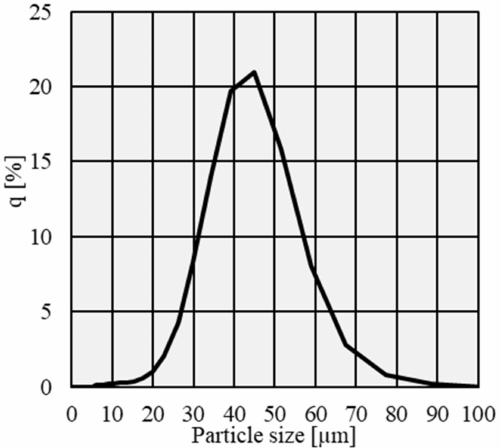
Figure 2. Particle size distribution of AISI 318LN